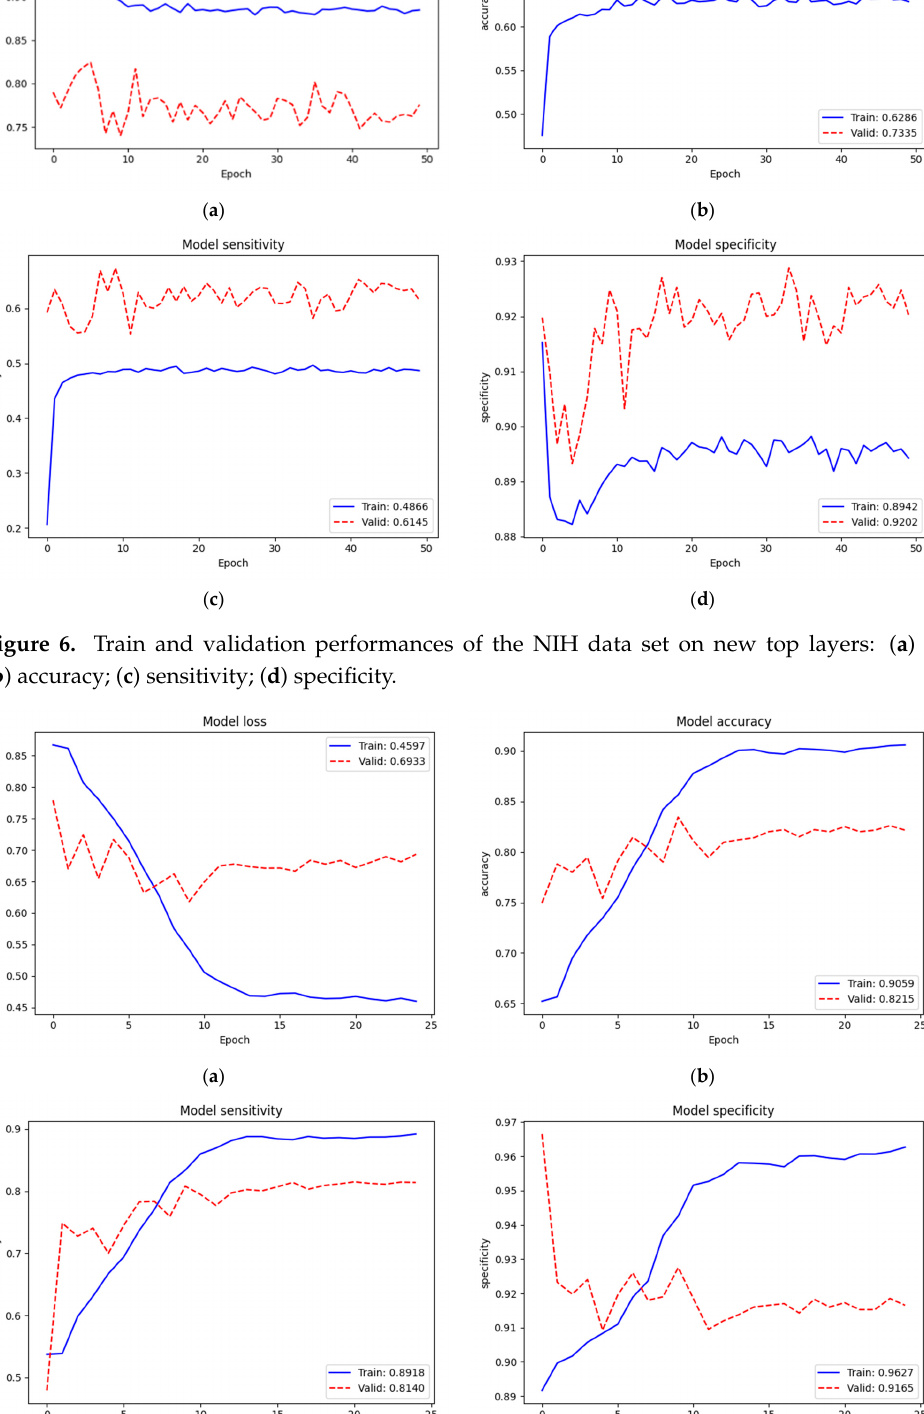
Table 9. Summary of the validation performance of the NIH data set.